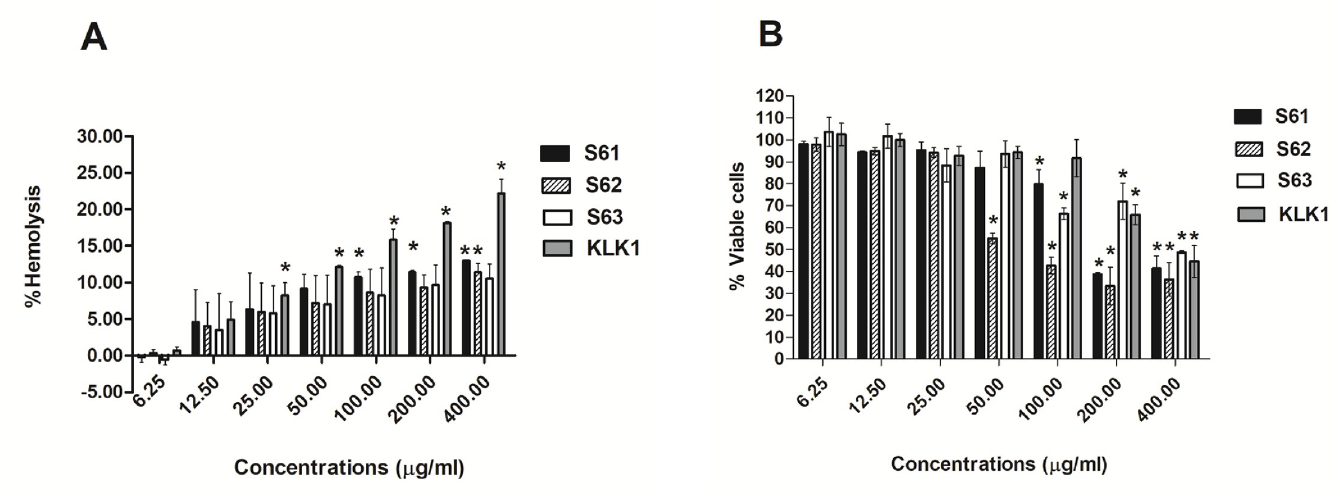
Fig 2. Toxicity testing of 4 potential AMPs to human red blood cells (RBCs) and peripheral blood mononuclear cells (PBMCs). Percent hemolysis of human RBCs after treatment with various concentrations of four AMPs for 1 h. (A). Percent PBMCs viability after treated with various concentrations of four AMPs for 1 h. (B). The data exhibited mean ± S.D. of duplicates from two independent experiments. One-way ANOVA followed by Tukey’s test was used to determine significant differences ( � P < 0.05). MIC of S61, S62, S63 and KLK1 were 6.25, 12.5, 9.38 and 37.5 μ g/ml.